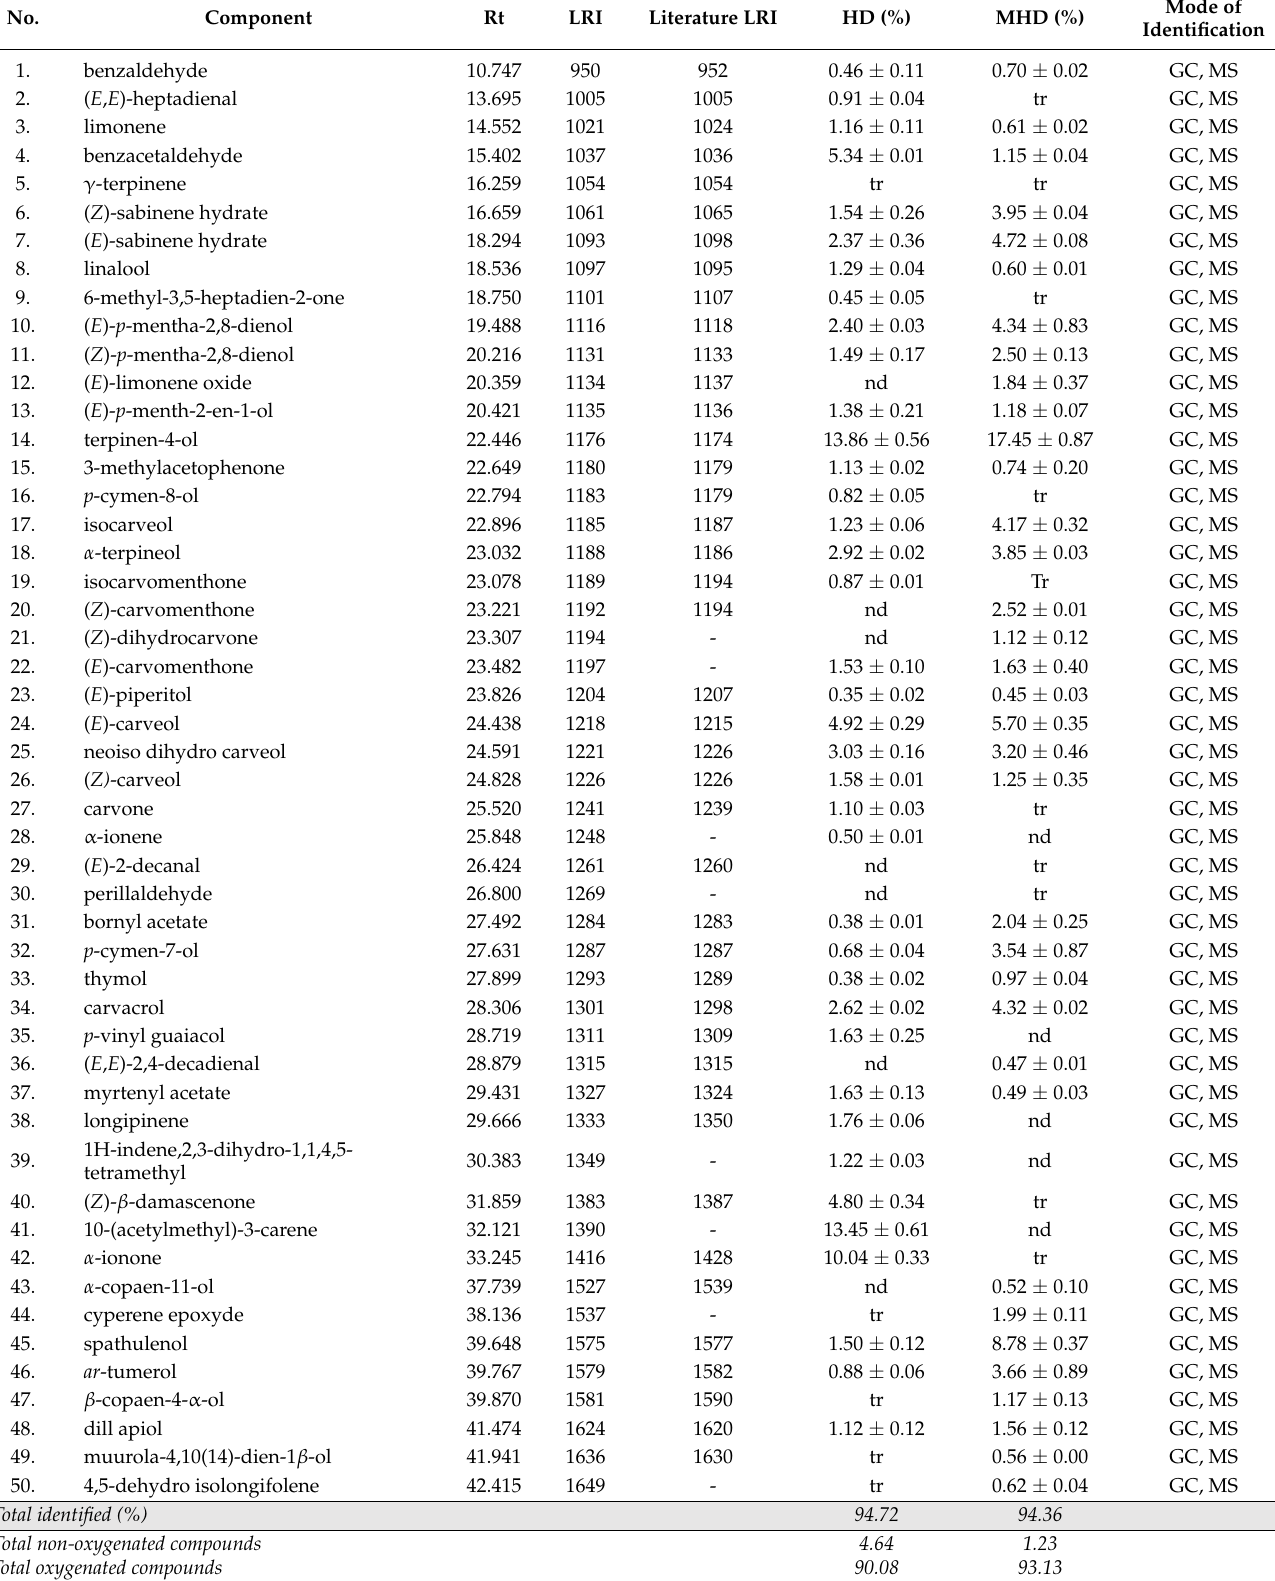
Table 2. HS-SPME-GC-MS analysis of sea fennel hydrolates obtained by hydro-distillation (HD) and microwave-assisted hydro-distillation